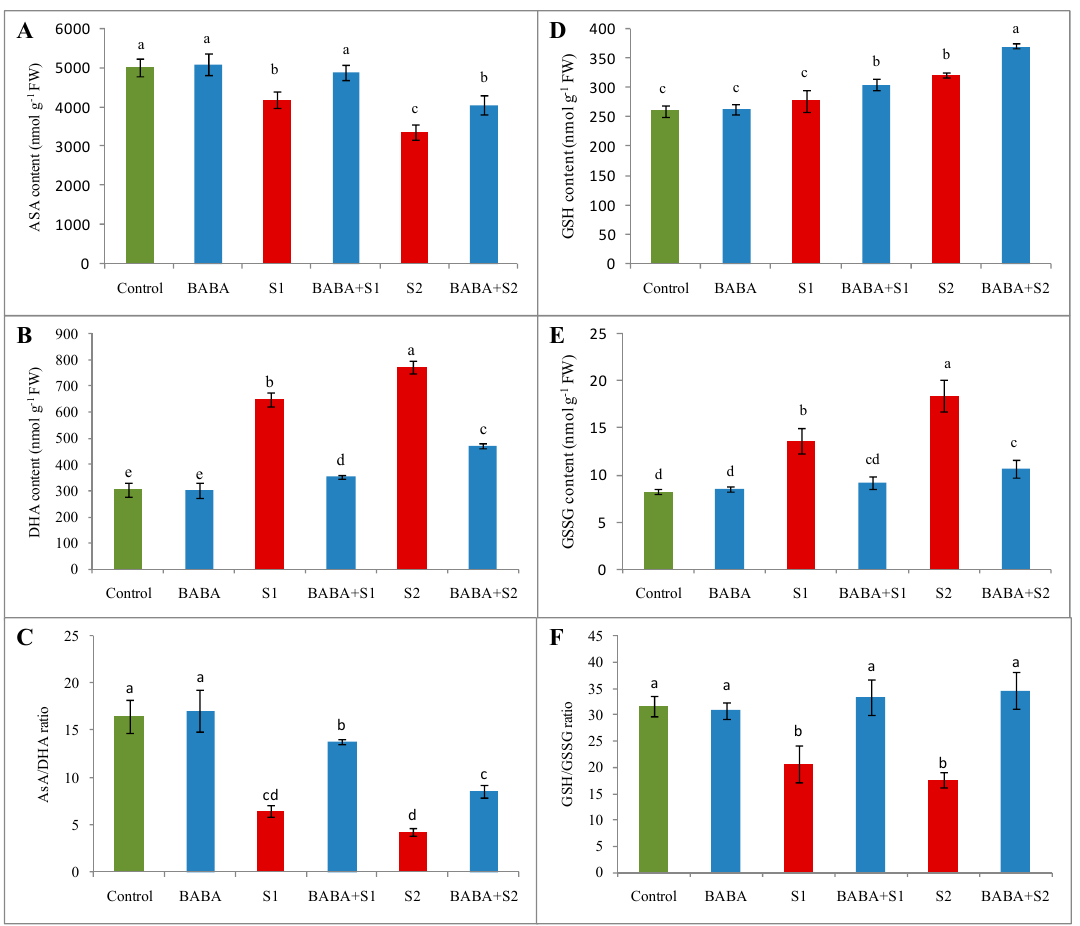
Figure 3. E ff ect of BABA on ascorbate (AsA) ( A ) and dehydroascorbate (DHA) ( B ) contents, AsA / DHA ratio ( C ), glutathione (GSH) ( D ) and oxidized GSH (GSSG) ( E ) contents, and GSH / GSSG ratio ( F ) of rapeseed ( Brassica napus L.) seedlings exposed to di ff erent concentrations of salt stress. Average from three replications (n = 3) was used to determine mean ( ± SD) for each treatment. Letters with di ff erent values varied significantly at p ≤ 0.05 according to Fisher’s LSD test. Here, BABA, S1 and S2 indicate 150 μ M β -aminobutyric acid, 100 mM NaCl and 150 mM NaCl, respectively. Glutathione (GSH), the key non-enzymatic antioxidant, was enhanced by 7% due to 100 mM and 24% due to 150 mM NaCl stress, whilst oxidized GSH (GSSG) content enhanced by 65% due to 100 mM and 123% due to 150 mM NaCl stress. Consequently, the ratio between GSH and GSSG reduced by 35% and 44% under 100 and 150 mM NaCl concentrations, respectively. Conversely, in contrast to respective stress treatments, BABA supplementation enhanced GSH content further by 10% and 13%; reduced GSSG content by 32% and 42%; and enhanced the ratio of GSH and GSSG by 62% and 97% under 100 and 150 mM NaCl stress, respectively (Figure